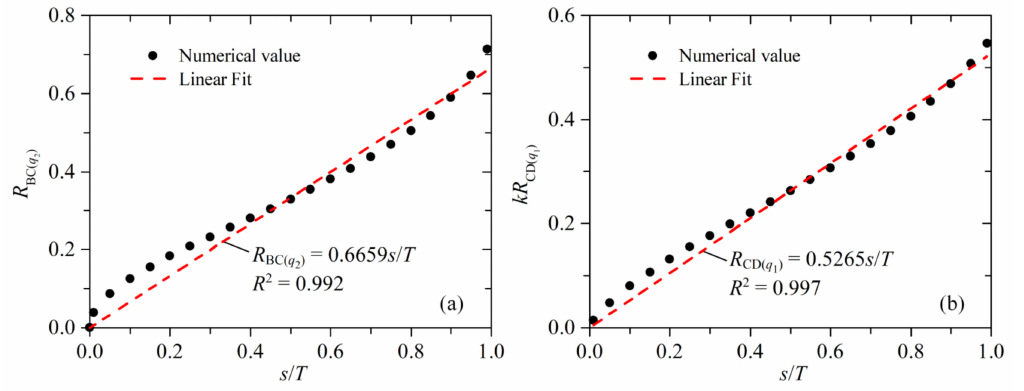
Figure 8. Linear fitting for ( a ) R BC( q